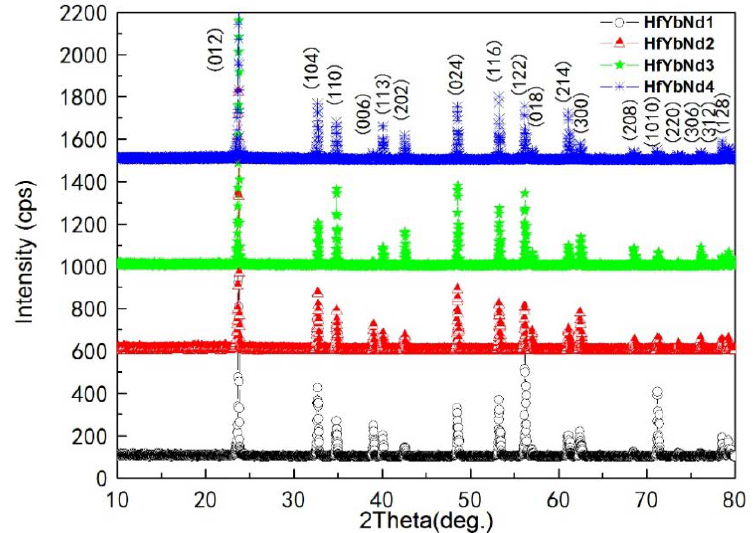
Figure 1. The X-ray diffraction pattern of Hf:Yb:Nd:LiNbO 3 crystals with different [Li]/[Nb] ratios. Table 1. Lattice constant of crystal